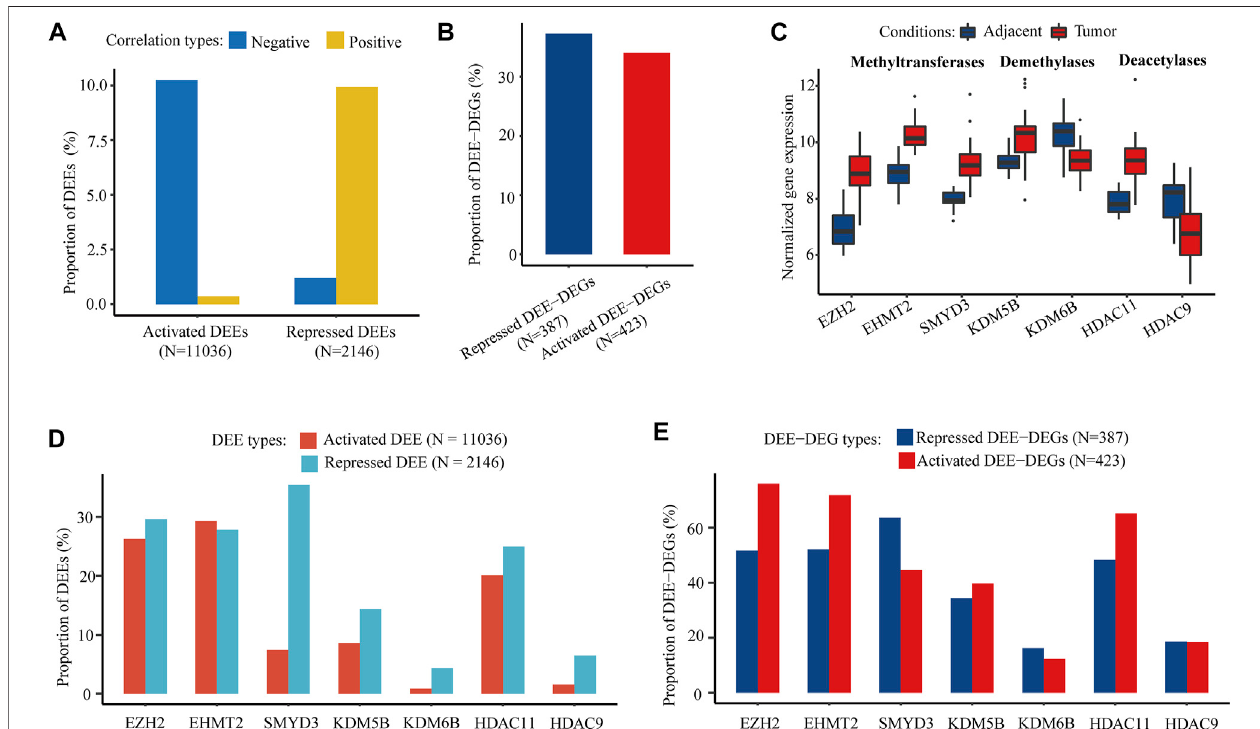
FIGURE 4 | DNA methylation and histone PTM modifer-associated intergenic DEEs and DEE-DEGs. (A) Percentage of DNA methylation-associated intergenic DEEs. (B) PercentageofDNAmethylation-associatedintergenicDEE-DEGs. (C) Signi fi cantdifferentialexpressionofsevenhistonemodi fi cationregulators(threehistone methyltransferases, two histone demethylases, and three histone deacetylases) in the discovery cohort. (D) Proportion of histone modi fi cation regulator-associated intergenic DEEs. (E) Percentage of histone modi fi cation regulator-associated intergenic DEE-DEGs.